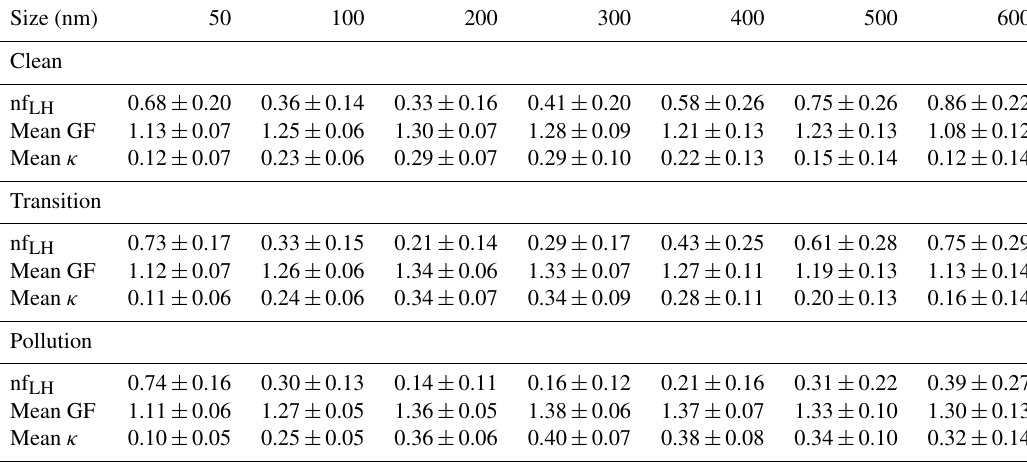
Figure 5. Panels (a) – (c) are the growth factor probability distribution under different pollution conditions. Panels (d) – (f) are the correspond- ing mean number size distribution for LH and MH mode. For comparison, we also mark the mean number size distribution under transition stage in dashed lines in panel (f) . Table 4. Statistical results of aerosol hygroscopic properties under different pollution